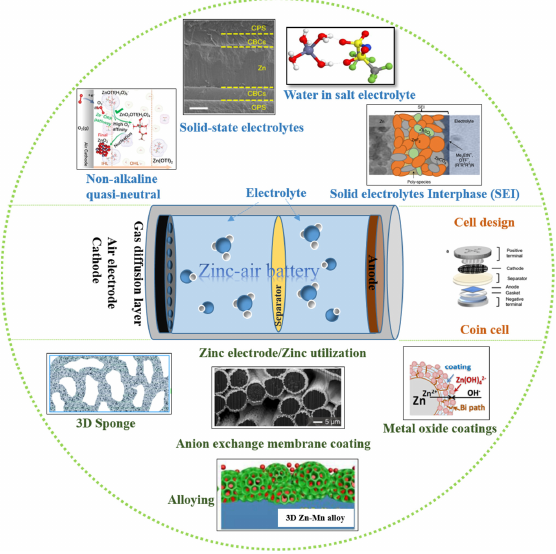
Figure 1. Overview of recent topical developments in zinc–air batteries